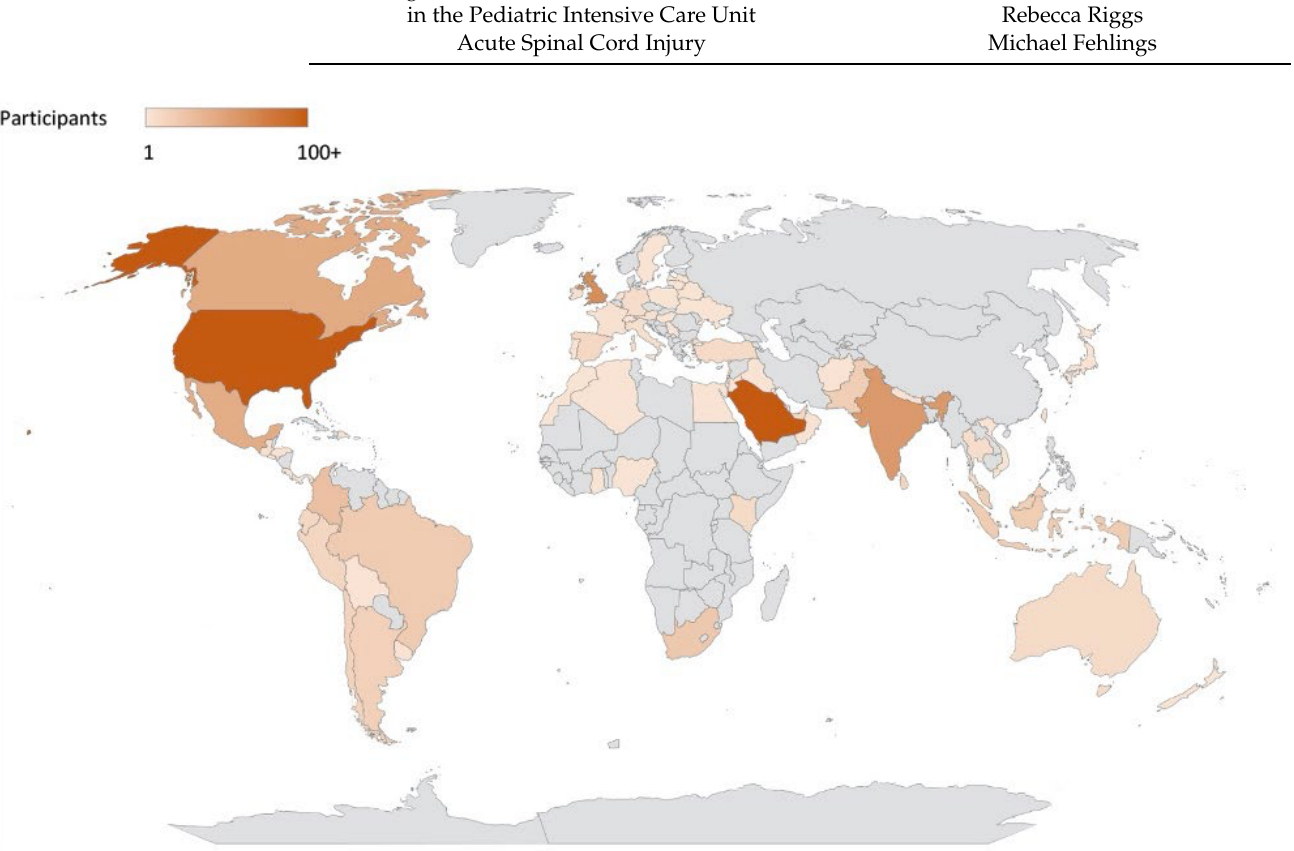
Figure 1. Participants in the PNCC Educational Series.